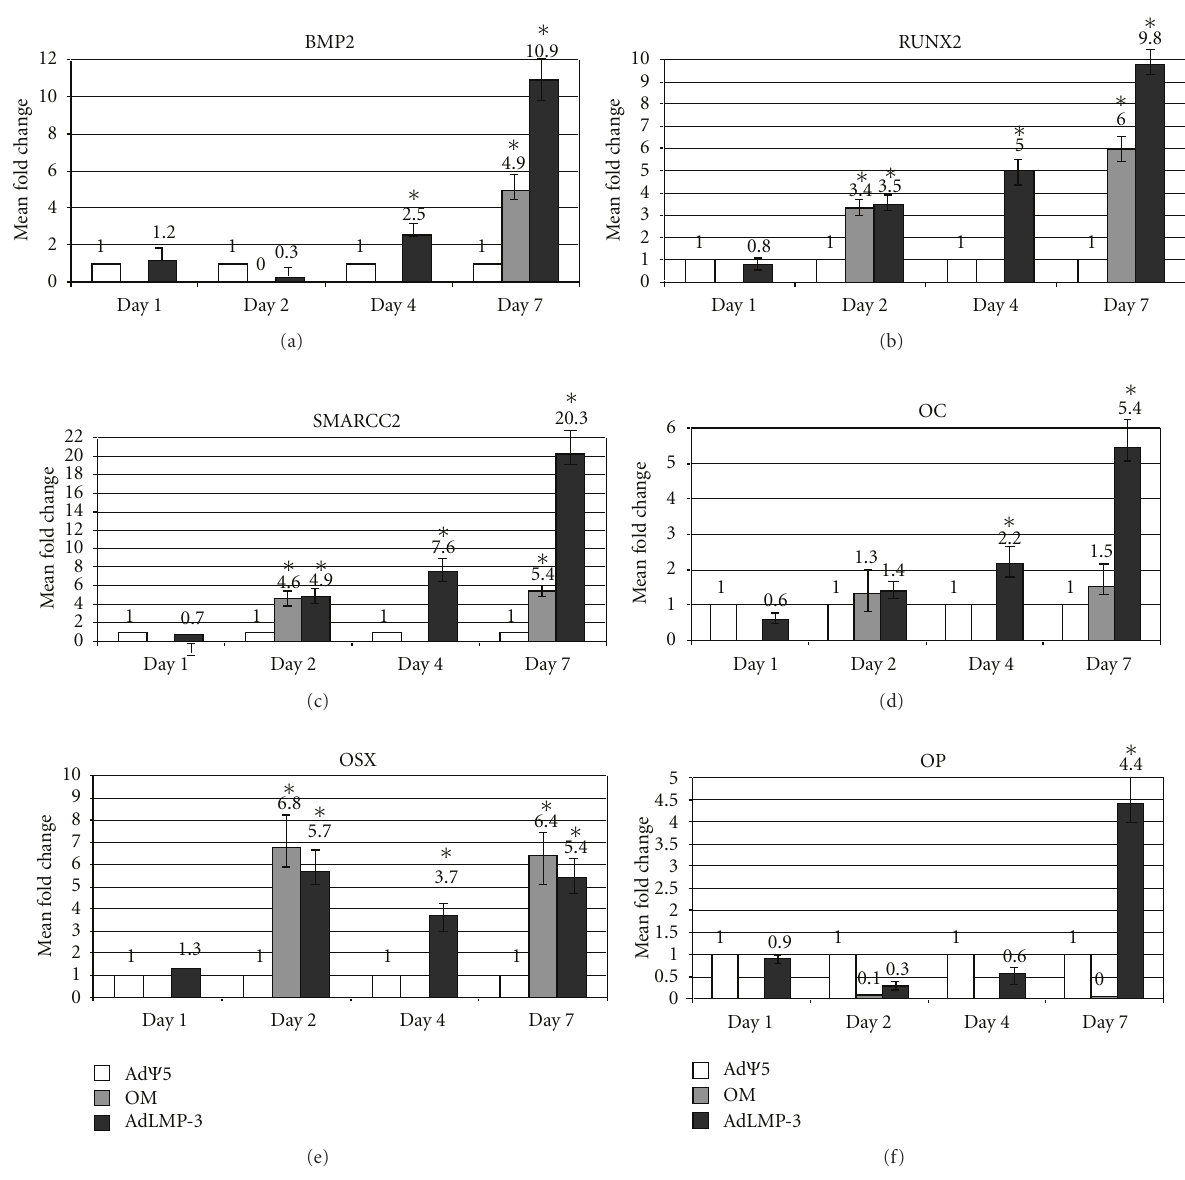
Figure 3: qPCR gene expression analysis. The graphic represents the expression levels of osteospecific gene ((a) BMP2; (b) RunX2; (c) SMARCC2; (d) OC; (e) OSX; (f) OP). Values represent the mean of triplicate experiments for each time point tested. Ad Ψ 5: mock- transduced control cells; AdLMP-3: treated cells; OM: cells cultivated in osteogenic medium as positive controls; d: days after cell transduction (4d-time point was not assessed in OM-cells); ∗ : statistical significance, P < 0 . 05. Fold change was calculated according to the 2 − ΔΔ Ct